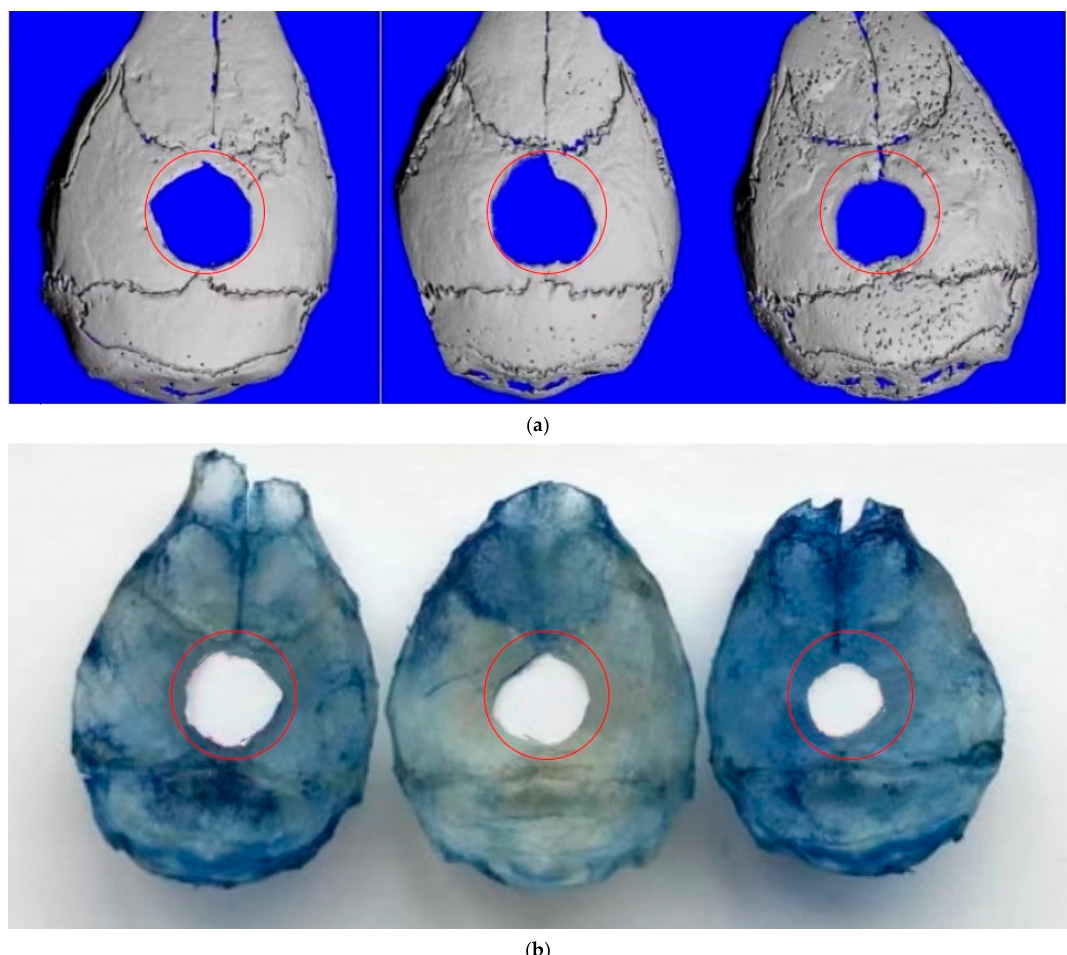
Figure 2. Calvarial defect between groups. The red circles mean the same size image and region of interests. ( a ) Three-dimensional reconstruction of skull by using a micro-CT. ( b ) Aniline blue skeleton staining. (Three groups: the TAMc group, the Oil group, and the TAM group).